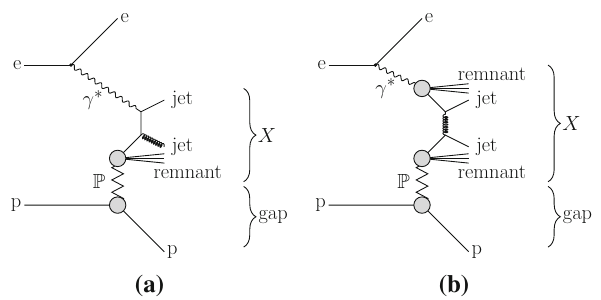
Fig. 1 Leading order Feynman diagrams for diffractive dijet produc- tionwithphotonsinepcollisions.Eitherthephotonparticipatesdirectly in the hard scattering matrix element ( a ) or a parton from the resolved photon participates ( b )